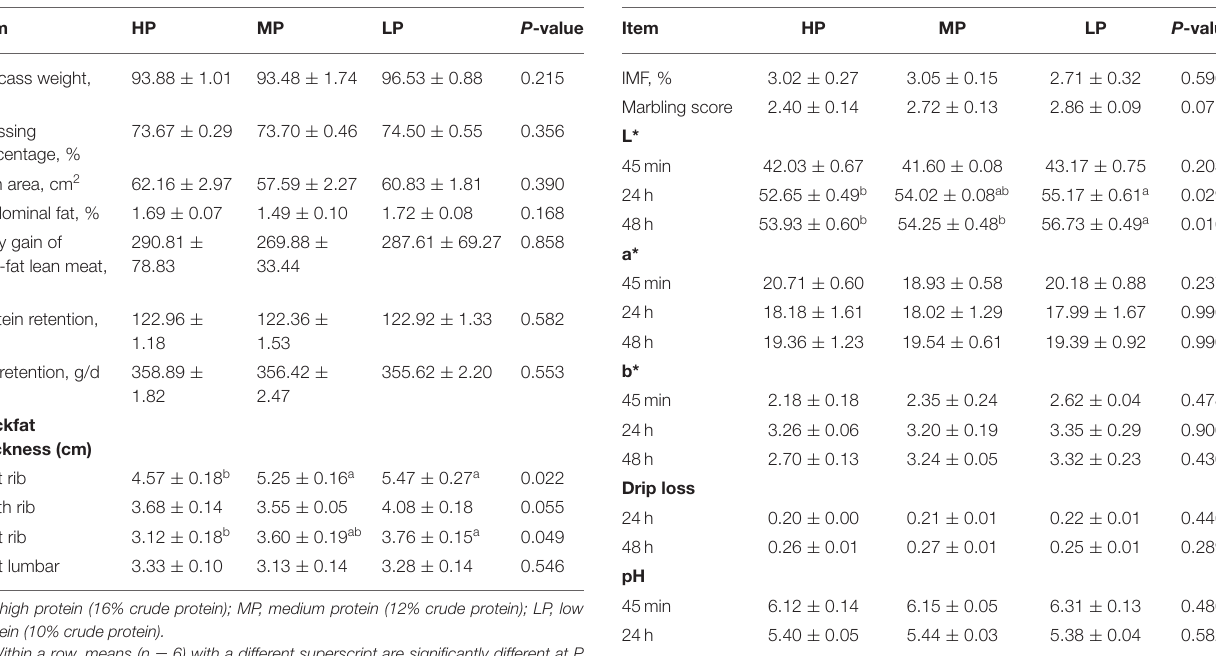
TABLE 4 | Effect of low protein diet on the carcass traits in finishing pig. TABLE 5 | Effect of low protein diet on the meat quality in finishing